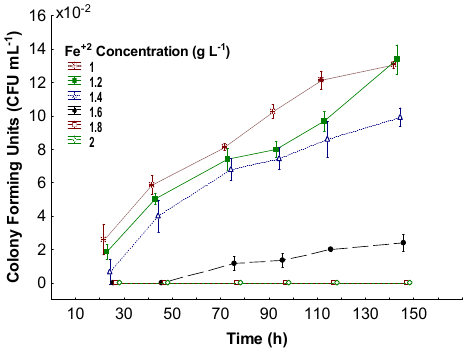
Figure 4. E ff ect of Fe + 2 concentration on the growth rate of B. halotolerans MCC1.